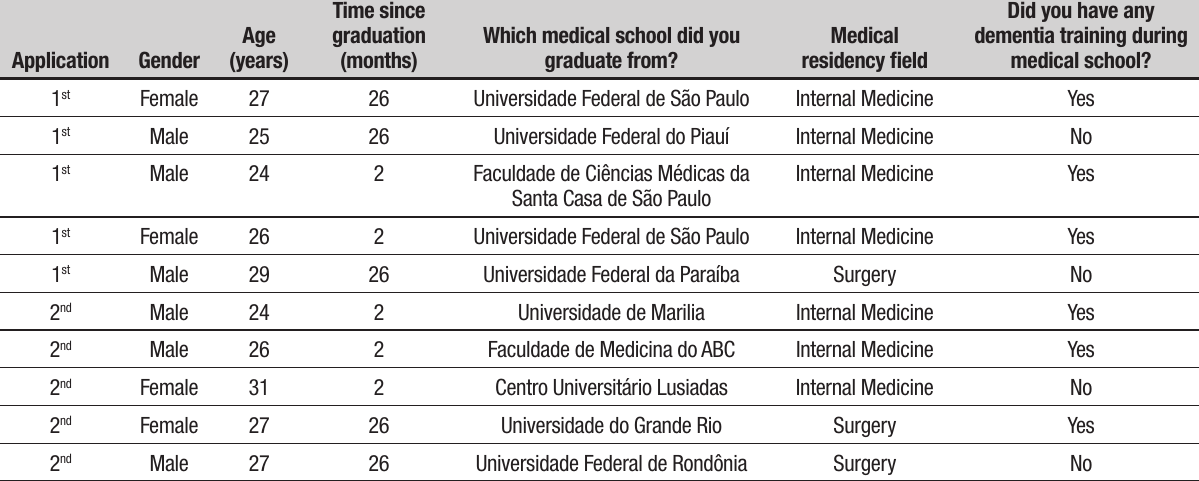
Table 3. Distribution of demographic and schooling characteristics of physicians who answered the instrument applications.